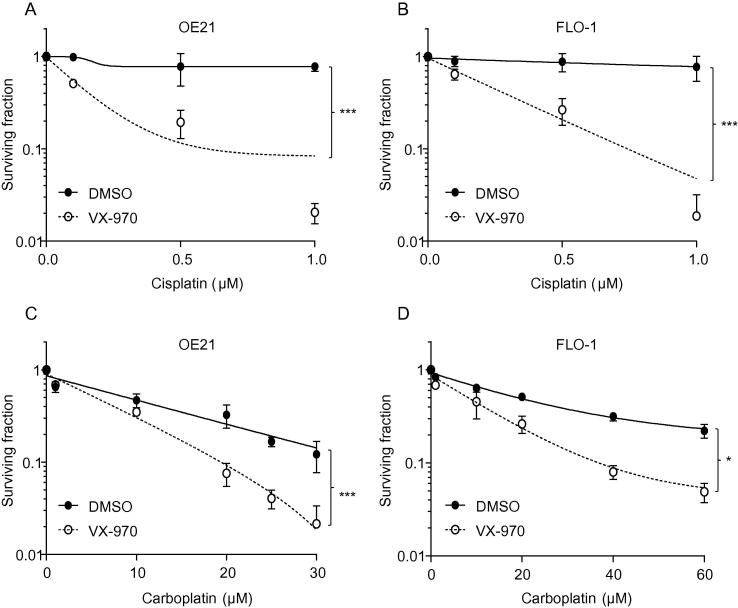
ATR inhibition with VX-970 increases the sensitivity of esophageal cancer cells to cisplatin and carboplatin. OE21 (A) and FLO-1 (B) cells were exposed to a combination of VX-970 (50 nM) and cisplatin as indicated and a colony survival assay carried out. OE21 (C) and FLO-1 (D) were exposed to carboplatin and VX-970 (50 nM) and a colony survival assay carried out. Results shown are mean ± SEM (n = 3). Significance: Two-way ANOVA test, *P < 0.05; ***P < 0.001.